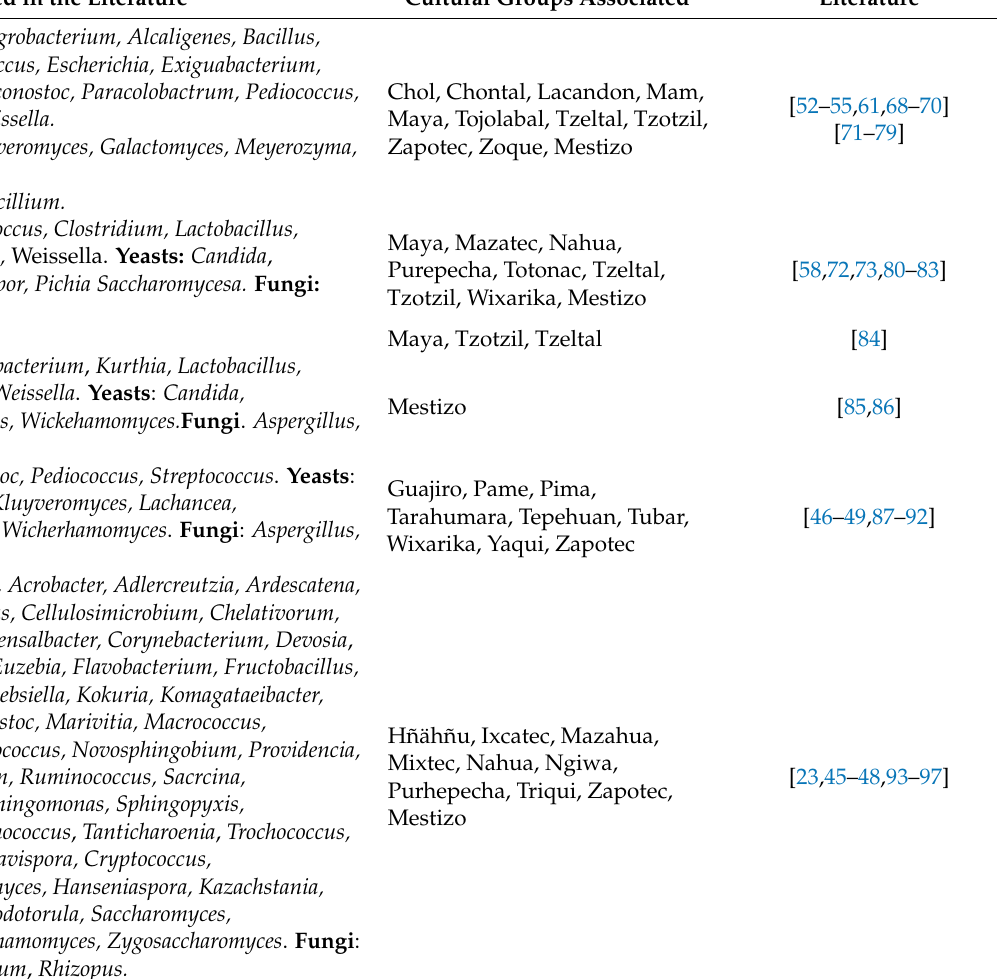
Table 1. Main traditional Mexican fermented beverages. Main substrates for fermentation, microorganisms described, and cultural groups associated to its production.